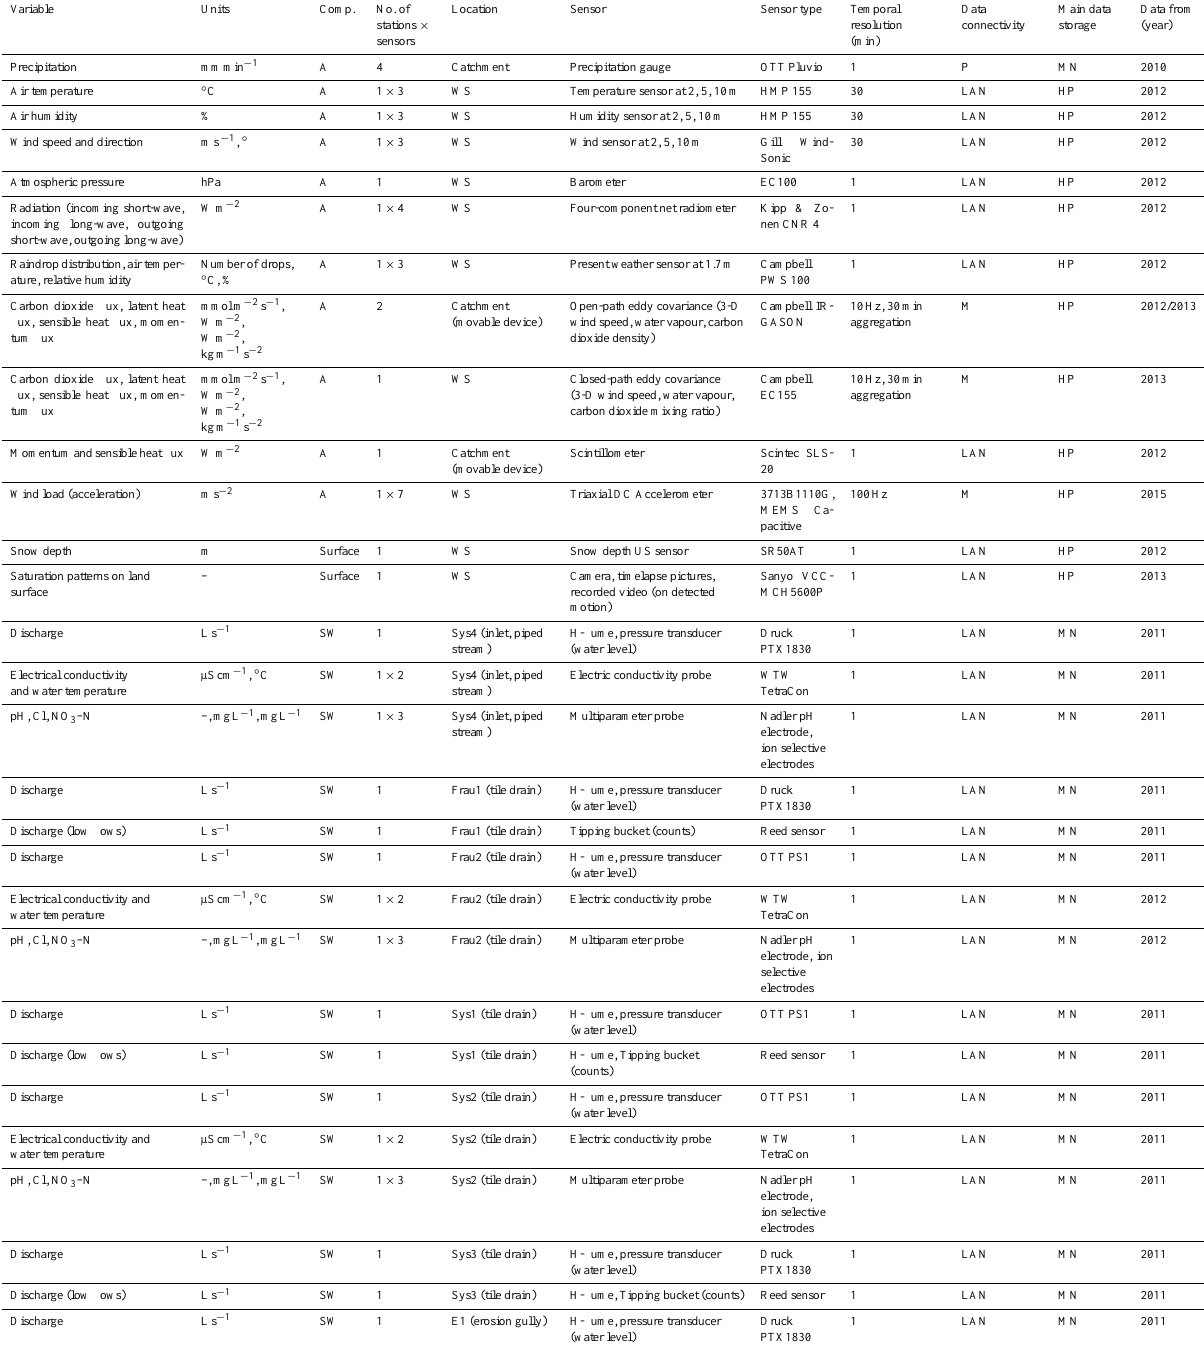
Table B1. Instrumentation in the HOAL. Compartments (Comp): GW = groundwater, SW = surface water, A = atmosphere. Location: MW = catchment outlet, WS = Weather station (also see Figs. 6 and 7). Data connectivity: LAN = glassfibre LAN, M = local storage and manual data transfer, P = GSM phone, S = satellite modem. Main data storage: Cosmos = Cosmos project server, HP = HOAL